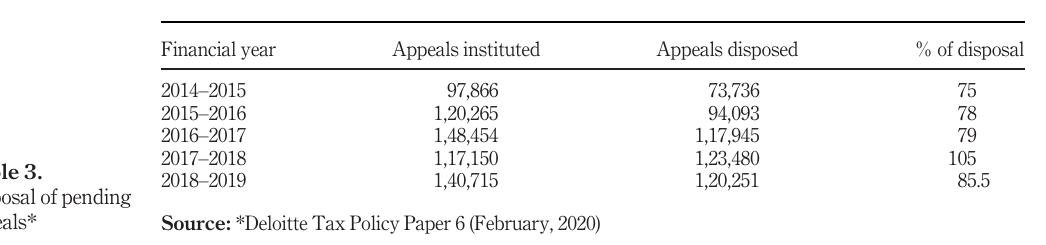
Table 2. Amount of CIT under dispute (w.e.f. 01-04- 2017 to 01-04-2019) [INR in Cr.]*